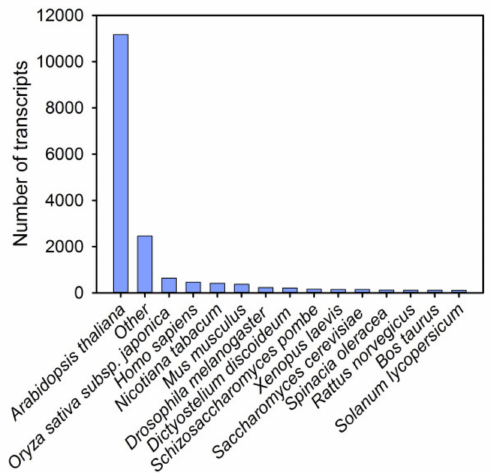
Figure 2. Species distribution of the top BLAST hits for total homologous sequences. Among them, the species with the most hits was Arabidopsis thaliana